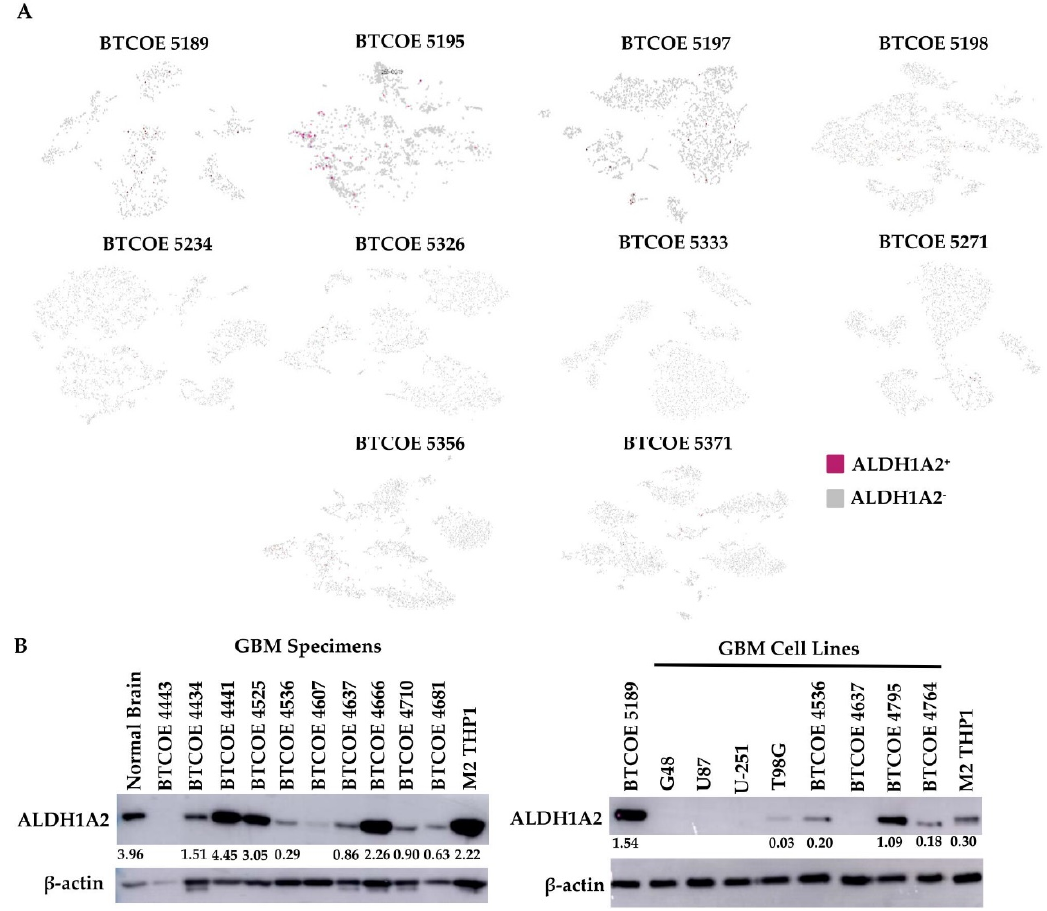
Figure 6. ALDH1A2 expression in GBM tumors. ( A ) Single-cell sequencing was performed on the CD45 + immune infiltrate of GBM tumors. ( B ) Expression of ALDH1A2 in lysates of GBM tumors (left panel) and in a panel of GBM cell lines (right panel) (representative of at least 3 blots).